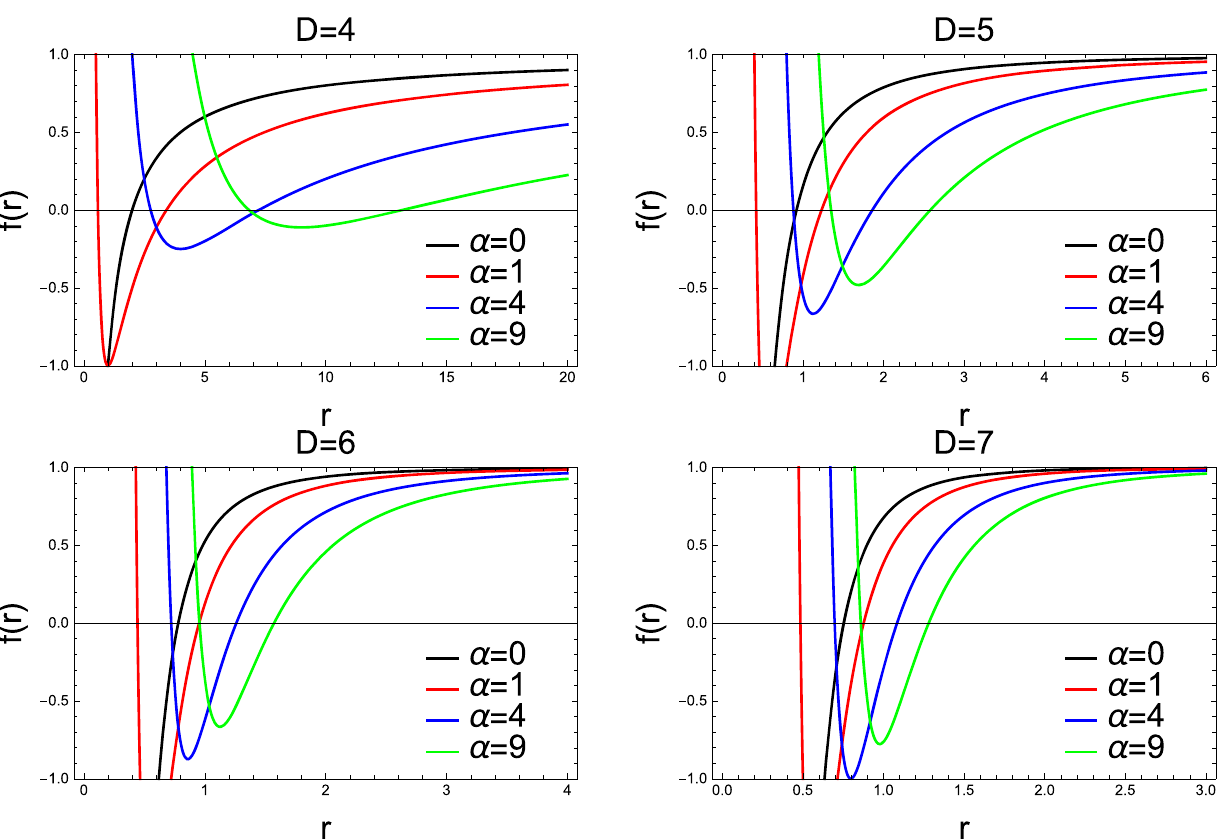
Fig. 1 Function f ( r ) with respect to r for different values of α , where the spacetime dimension is taken to be D = 5 , 6 , 7, respectively, and the case of D = 4 is attached for comparison. Here we set M =